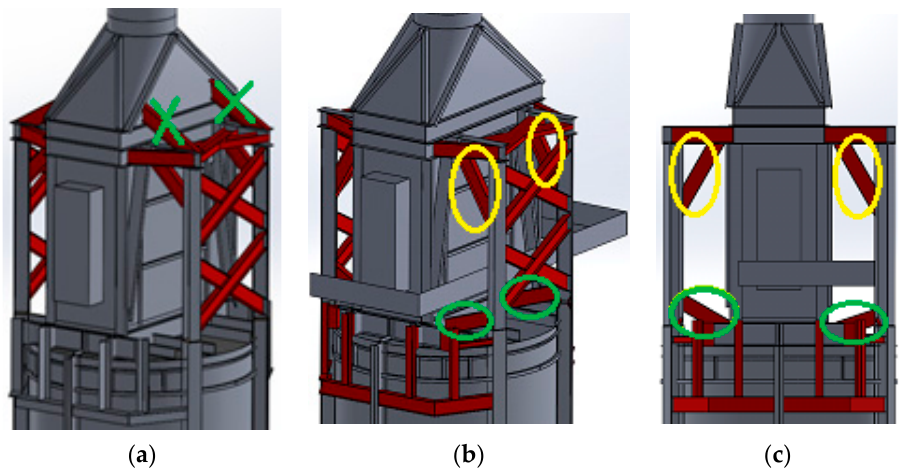
Figure 10. Numerical model for Case 9. ( a ) Case 8 (The braces with green marks are removed.); ( b ) Case 9 (The braces with green marks are added and the brace angles with yellow marks are changed, similar for ( c )), ( c ) Case 9.